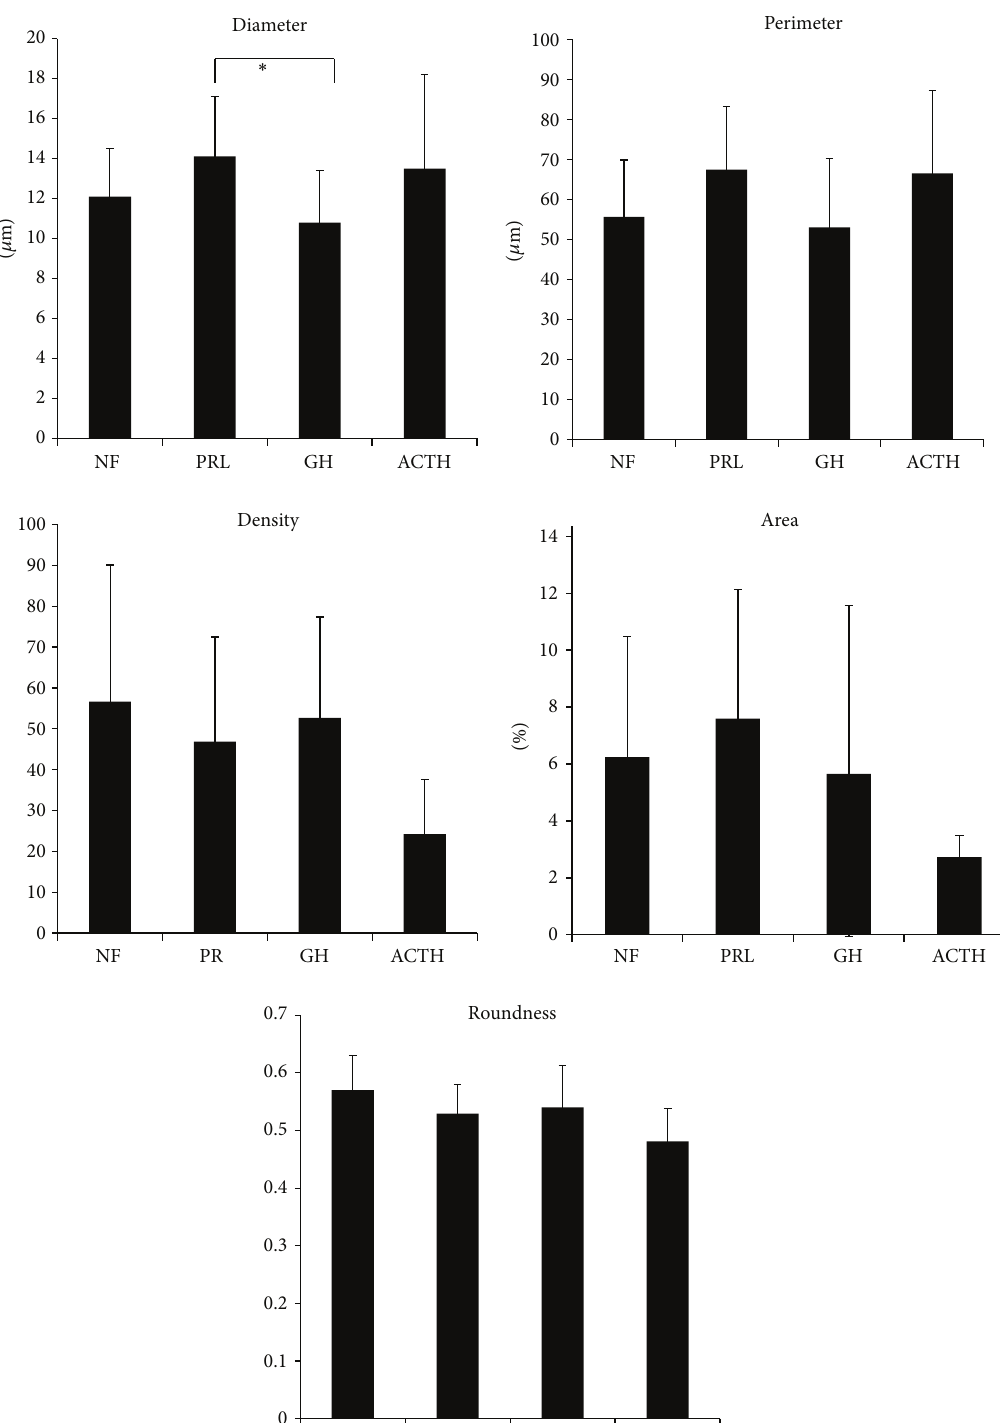
Figure 4: Differences in the vascular architecture of all types of pituitary adenomas. Vessel diameter is significantly larger in prolactin- secreting adenomas than GH-secreting adenomas. Vessel density, area, and roundness are lower tendency in ACTH-secreting adenoma than nonfunctioning adenomas. ∗ 𝑃 < 0.05